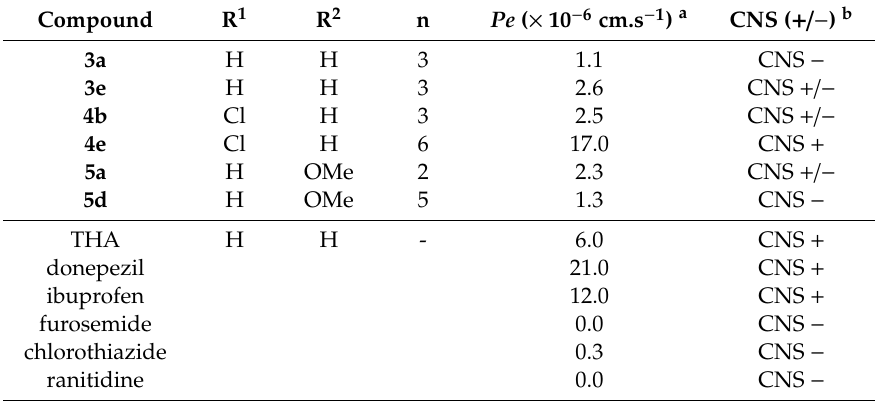
Table 3. Prediction of BBB penetration of the studied compounds expressed as Pe